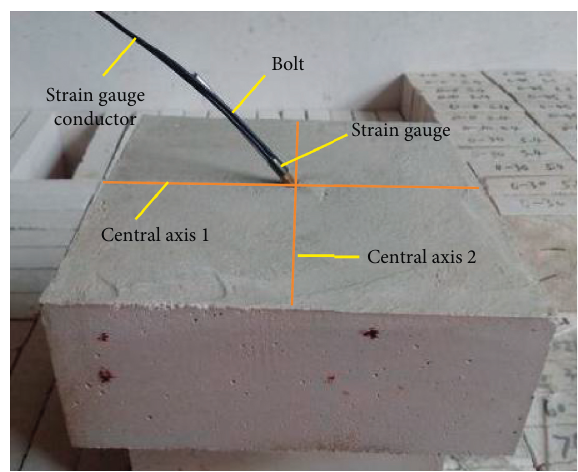
Figure 3: Center axis on the joint.